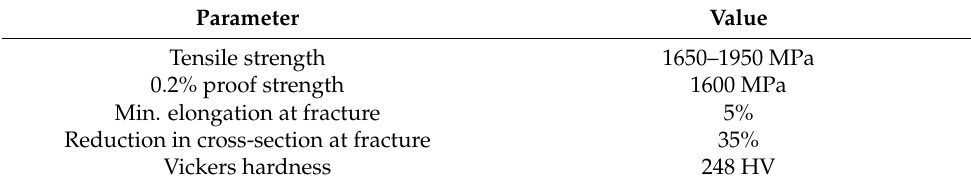
Table 2. Mechanical properties of the steel according to the standard CSN EN 10089-03.